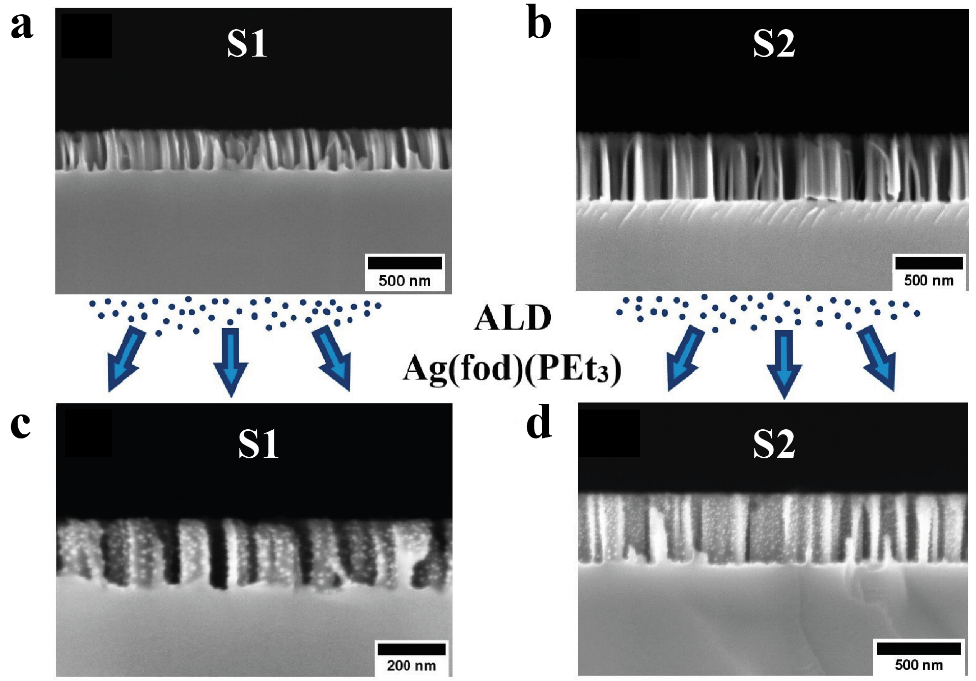
Figure 4. Cross-section SEM images of the initial arrays of SiNWs: ( a ) S1 and ( b ) S2; and after the deposition of AgNPs by ALD method: ( c ) Ag/SiNWs_S1 and ( d ) Ag/SiNWs_S2.